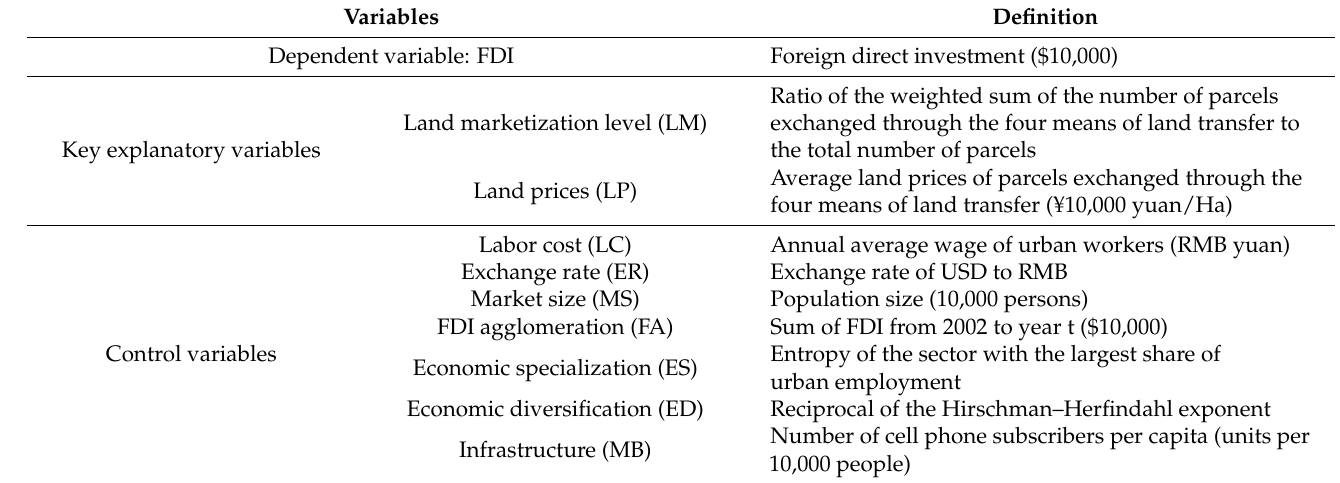
Table 1. Variable definitions.